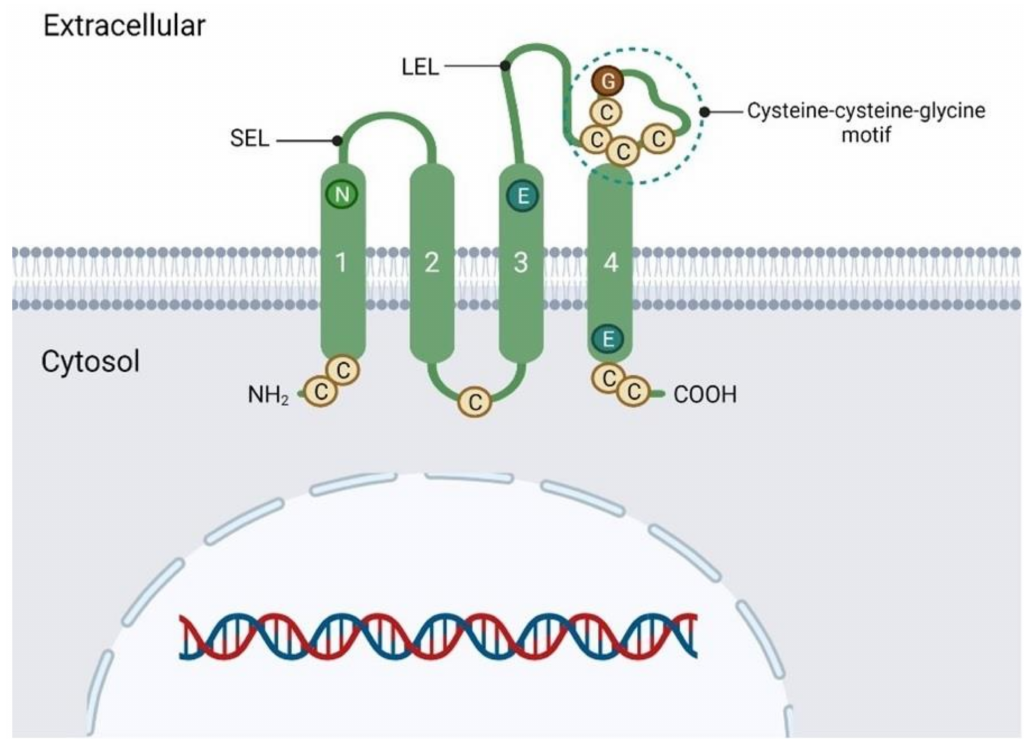
Figure 1. Structure of transmembrane 4 L6 domain.